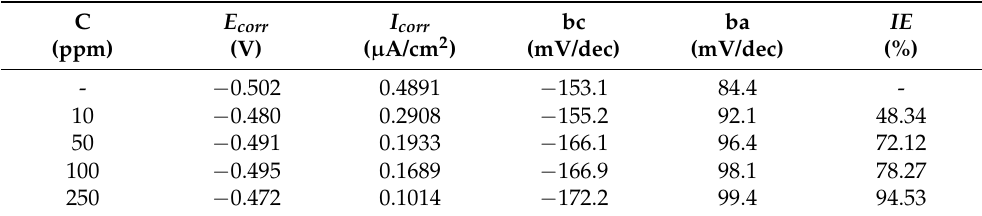
Table 2. Electrochemical parameters of mild steel at various concentrations of Pantoprazole molecules in 1 M sulfuric acid.